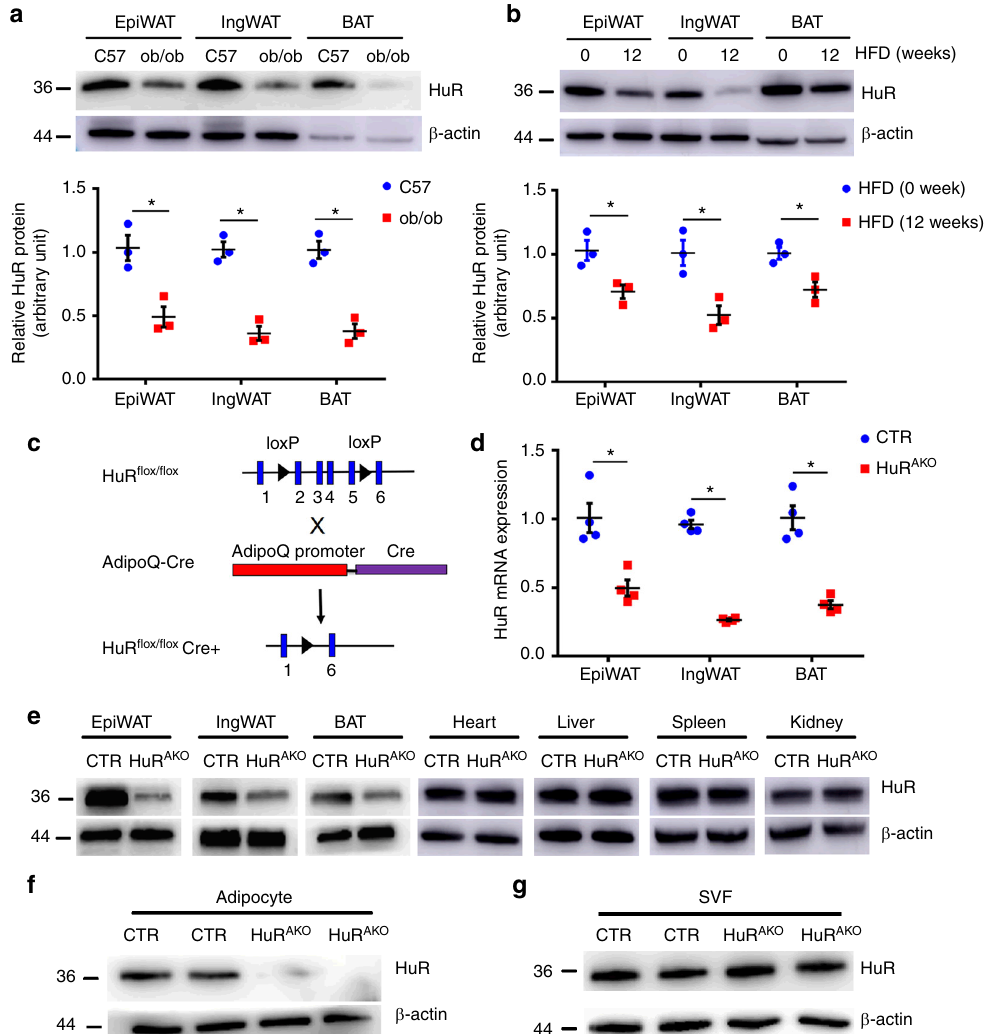
Fig. 1 Generation of adipose-speci fi c HuR -knockout mice. a Western blot analysis of HuR protein expression in adipose tissue (epiWAT, ingWAT and BAT) of 20-week-old C57BL/6J and ob/ob mice and quanti fi cation ( n = 3), *comparison of ob/ob vs. C57. b Eight-week-old male C57BL/6J mice were fed with an HFD for an additional 12 weeks; western blot analysis of HuR and β -actin in adipose tissue and quanti fi cation ( n = 3), *comparison of HFD (12w) vs. HFD (0w). c Schematic diagram of transgenic mice used to generate HuR AKO mice. d qPCR analysis of HuR mRNA expression in adipose tissue from control and HuR AKO mice ( n = 4), *comparison of HuR AKO vs. control. e − g Western blot analysis of HuR protein level in tissues ( e ) and adipocytes ( f ) and stromal vascular fraction (SVF) ( g ) from control and HuR AKO mice. Data are represented as mean ± SEM. Signi fi cance was determined by Student ’ s t test analysis, * P < 0.05. Source data are provided as a Source Data fi